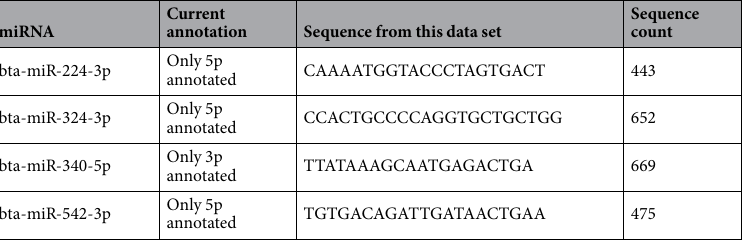
Table 1. Suggested updates to bovine miRNA definitions from this data set. For bta-miR-340-5p and bta-miR- 542-3p, despite lack of annotation, a deep sequencing profile consistent with what is reported here is presented in